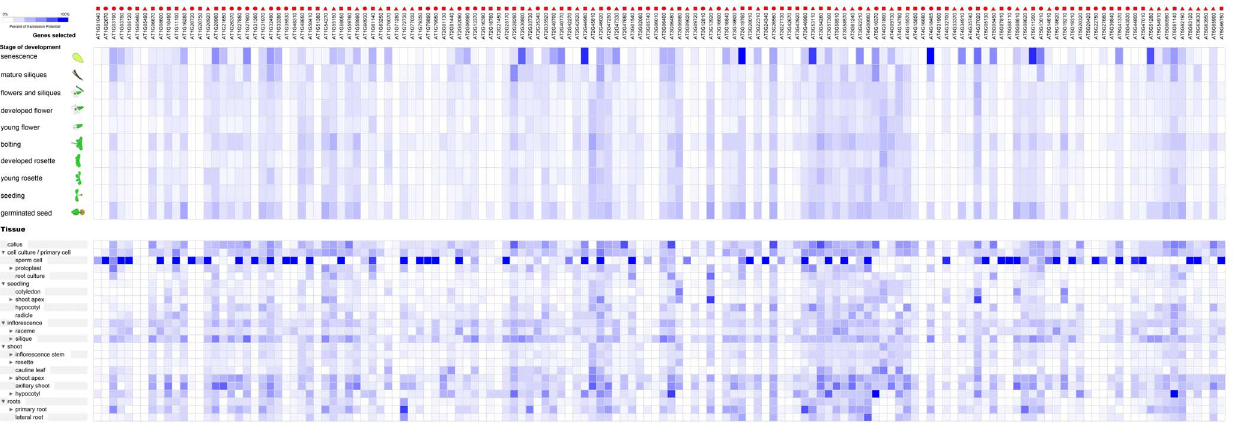
Figure 4. The expression profiles of 145 RNA helicase genes in Arabidopsis . The expression profiles of 145 RNA helicase genes in different development stages (above) and tissues (below) in Arabidopsis . The deep and light blue shading represents the relative high or low percent potential expression levels, respectively, of the helicase genes in different development stages and different tissues. The DEAD-box, DEAH-box and DExD/H- box RNA helicase genes are indicated by the red triangle, circle and square, respectively.